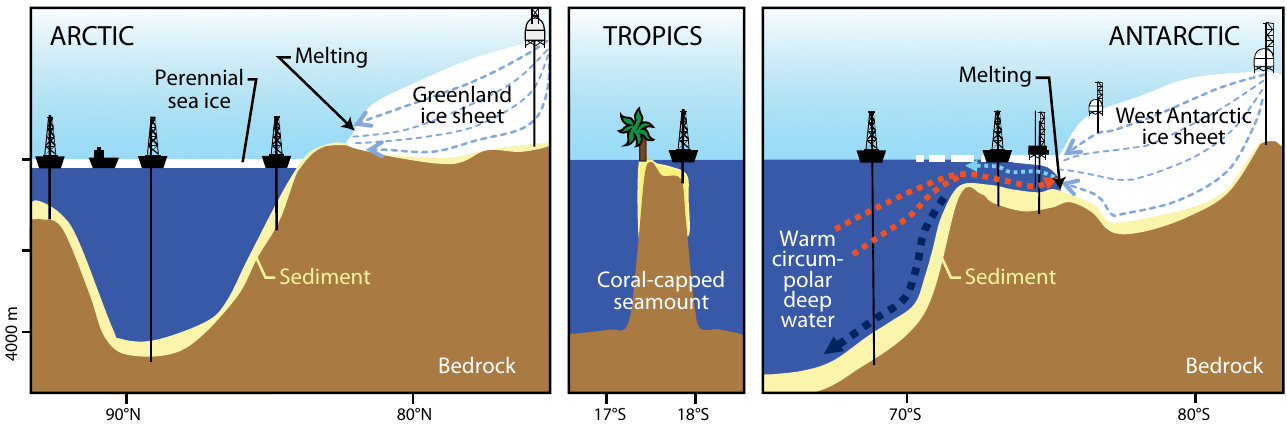
figure 2.6. proposed drilling strategy from pole to pole using international ocean discovery program drilling platforms to collect records linking climate, ice sheet, and sea level histories on geologic time scales. The climate history derived from these records is used to ground-truth and test the performance of numerical ice-atmosphere- ocean models, thus improving their ability to project future sea level rise. ice and coral records are best preserved over the last 100,000 years, antarctic ice cores go back 850,000 years, and sediment records extend back tens of millions of years. red arrows represent warm water flow beneath floating ice, recently recognized as a key factor in accelerating ice loss from West antarctica. elements of this figure were adapted from schoof